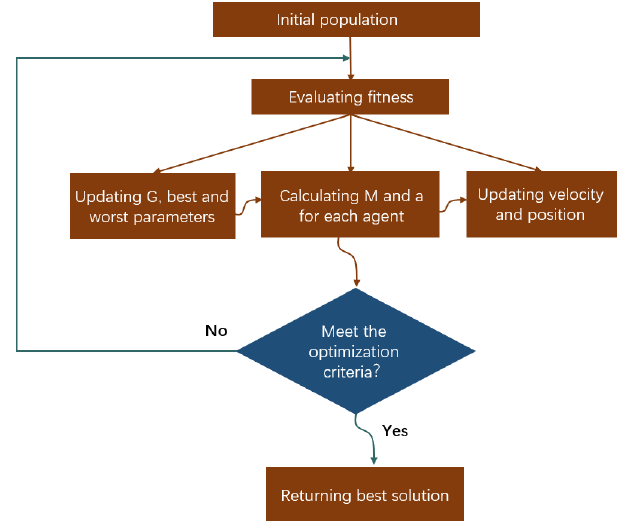
Figure 18. Flow chart displaying the